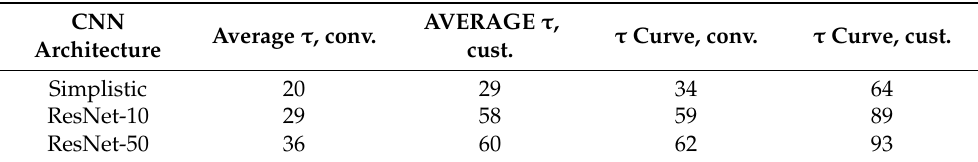
Table 3. A 1 average torque and torque curve prediction accuracy using conventional and custom